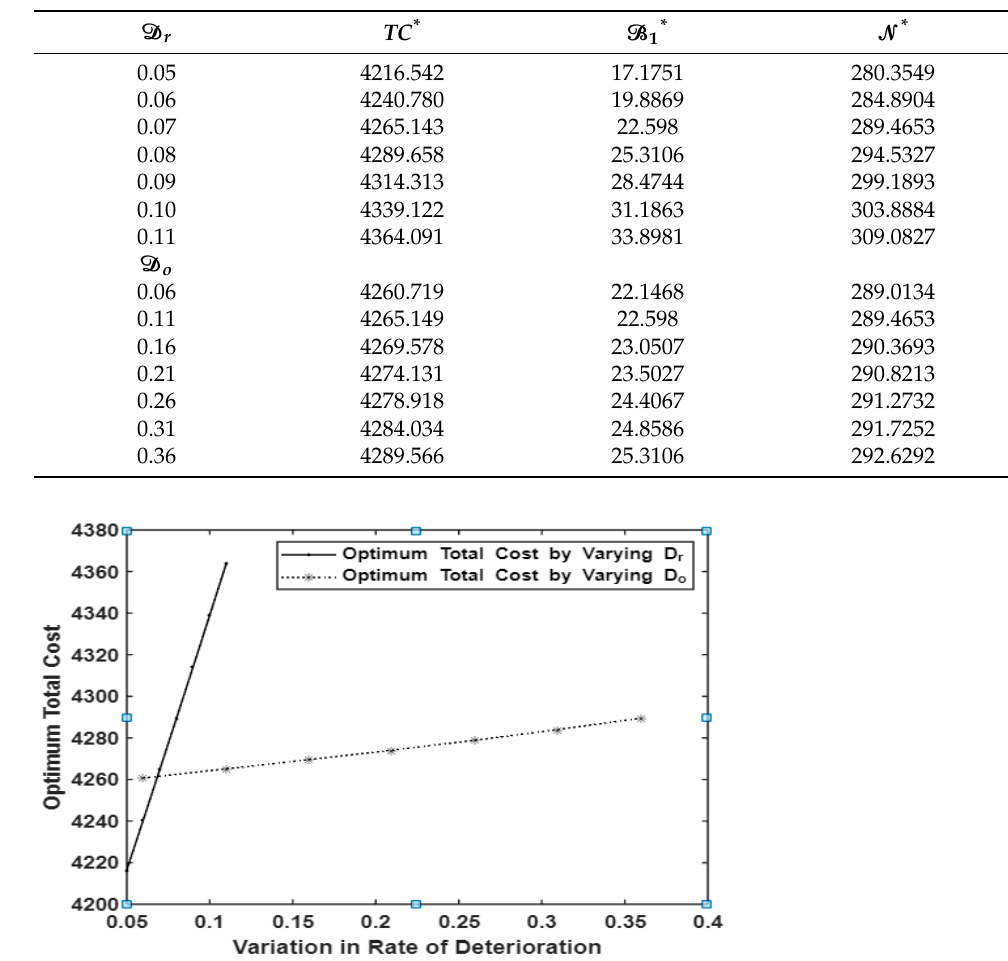
Table 4. The effect of changes in deterioration rate 𝒟 (cid:3045) and 𝒟 (cid:3042) on arriving optimal total cost and optimal ordering quantity.